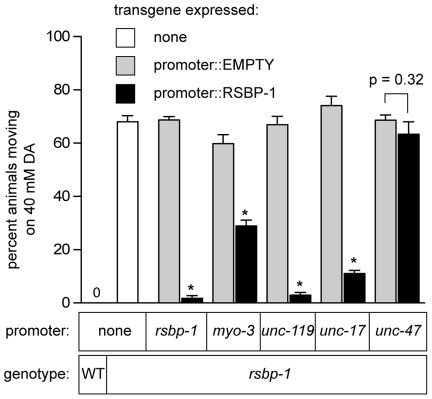
Rescue of rsbp-1 function by transgenic expression using cell-specific promoters.Animals were tested for paralysis as in Figure 2A, except that a single concentration of DA was used (40 mM). For control, non-transgenic animals (white bars), each measurement shown represents the mean and 95% confidence interval of the mean for at least 75 animals. Gray and black bars represent measurements from rsbp-1 mutants carrying transgenes. The promoters used for transgene expression are indicated at the bottom. Gray bars represent measurements form control strains carrying empty vector transgenes, which have promoters but no RSBP-1 sequences. We observed no significant differences in the response of these transgenic animals when compared to each other or to rsbp-1 null mutants that lacked transgenes (p<0.001). Black bars represent measurements from strains carrying transgenes from which the promoters express RSBP-1. For each transgene, measurements of at least 75 animals for each of two or three lines were averaged, and the means and 95% confidence intervals are shown. Asterisks indicate that RSBP-1 expression gave significant rescue compared to control animals that contained promoter but not RSBP-1 coding sequence. Asterisk indicates p<0.001. The intermediate response of myo-3p::RSBP-1 animals was different from both unc-47p::RSBP-1 animals (p<0.001) and from all other rescue strains (p<0.001). All comparisons done using one-way ANOVA with Bonferroni post hoc test. The unc-17 promoter gave nearly complete rescue of rsbp-1 while the unc-47 promoter had no significant effect (p = 0.32, student's t test) on behavior indicating that RSBP-1 acts in the cholinergic motor neurons and not the GABAergic neurons to mediate DA signaling.